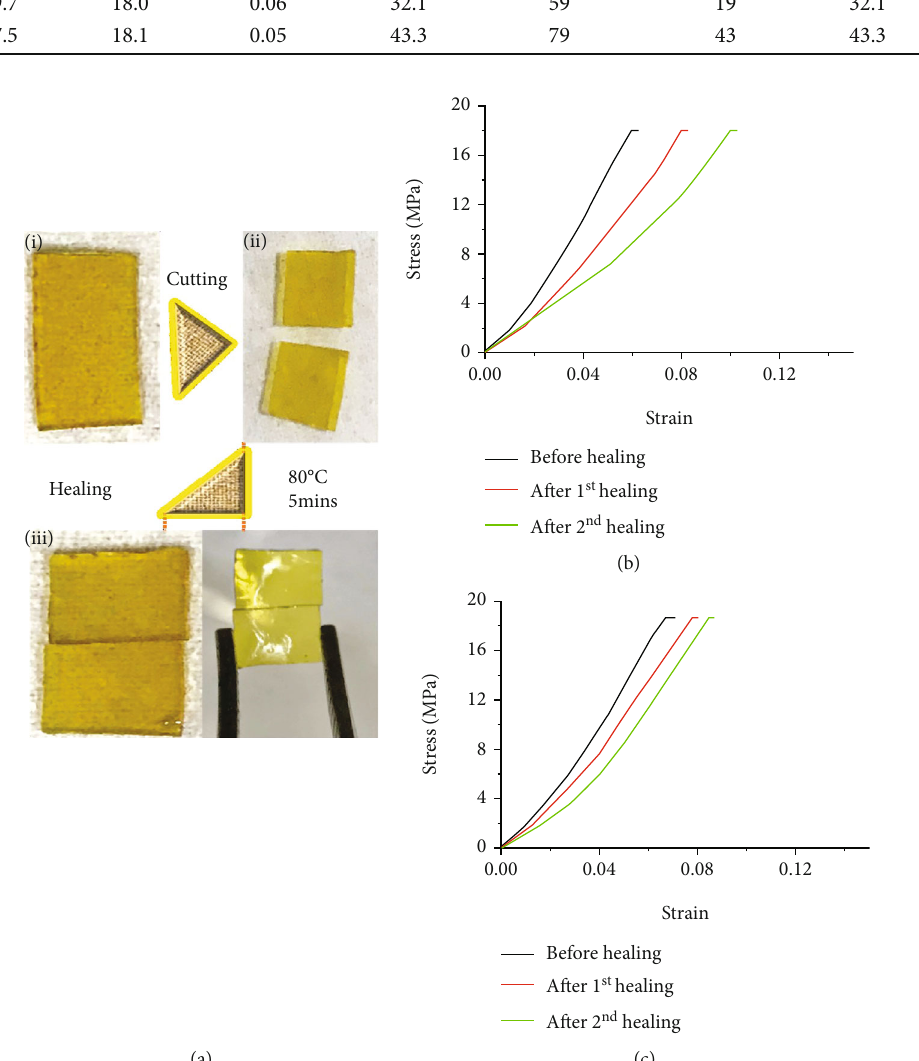
Figure 3: (a) Self-healing of epoxy vitrimer: (i) pristine EP-p, (ii) cut into two pieces, and (iii) rejoined. Healing e ffi ciency of vitrimer was calculated via the stress-strain relationship for (b) EP-p and (c) EP-1.